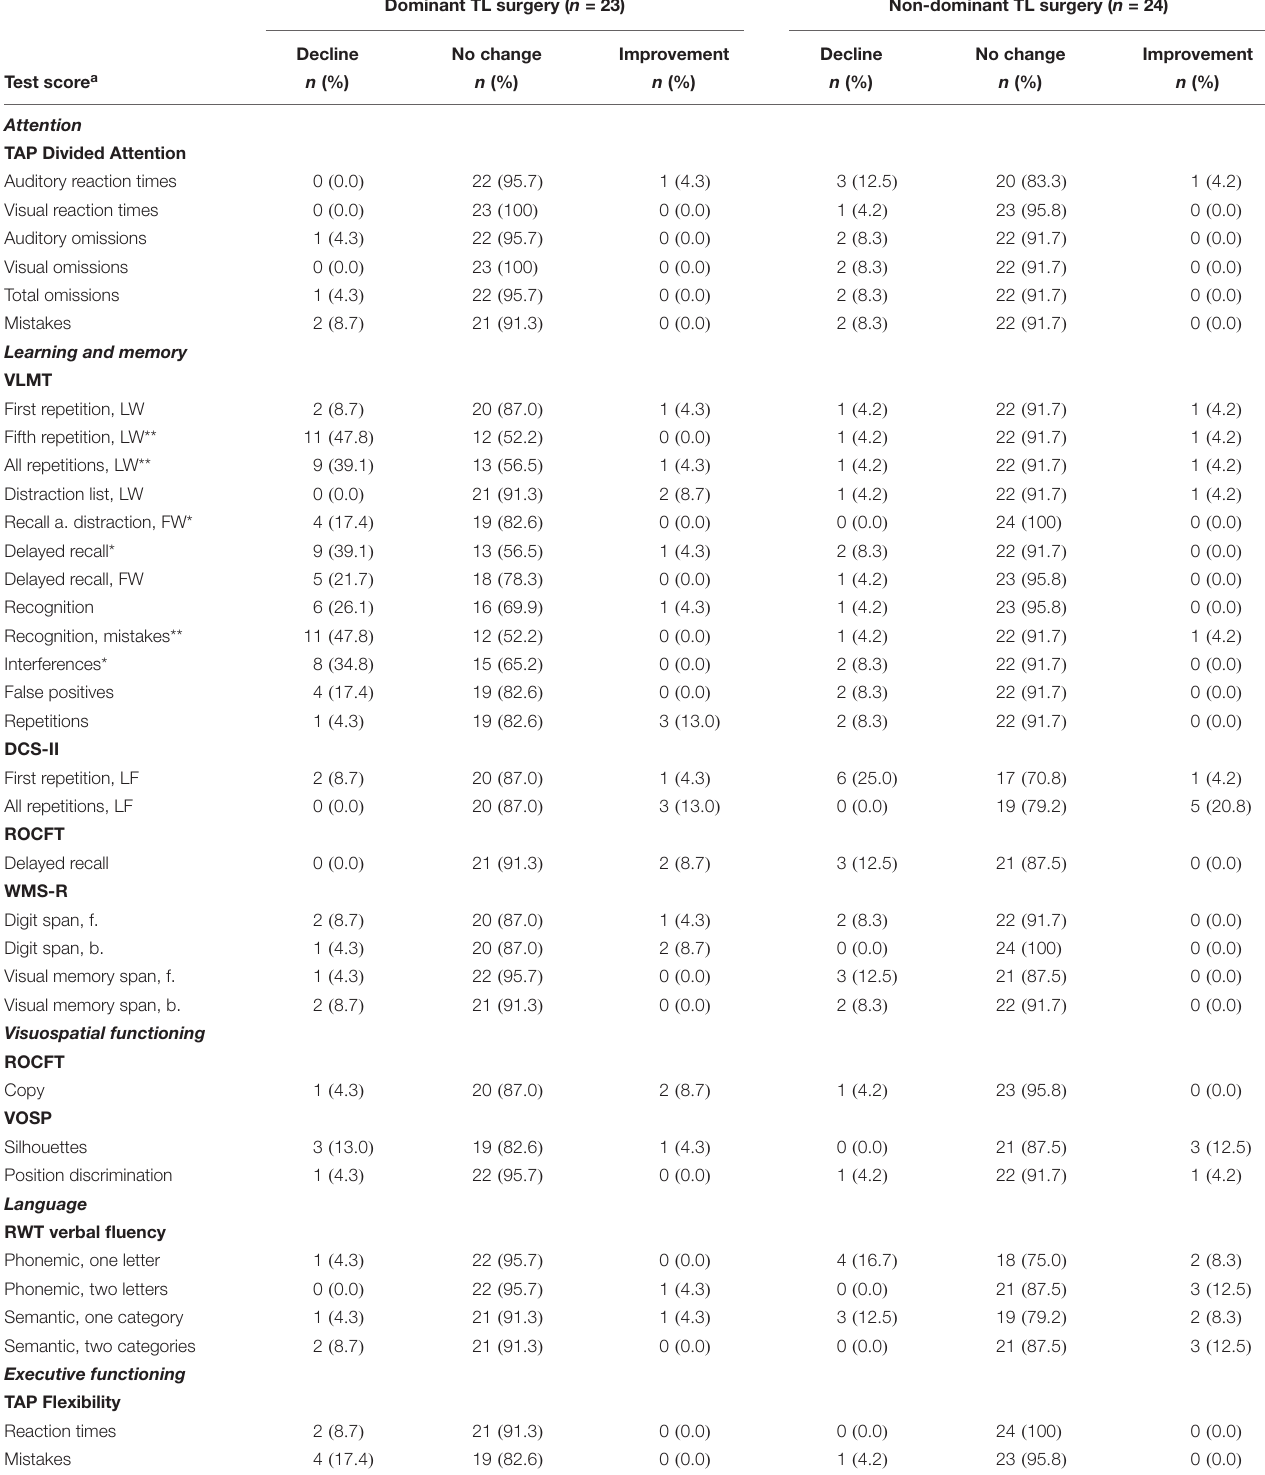
TABLE 5 | Proportion of patients achieving decline, improvement or no meaningful change in each neuropsychological test score (according to SRB change norms) and each scale of the self-report questionnaires (according to MCID thresholds), computed separately for the two subgroups (compared by chi-square